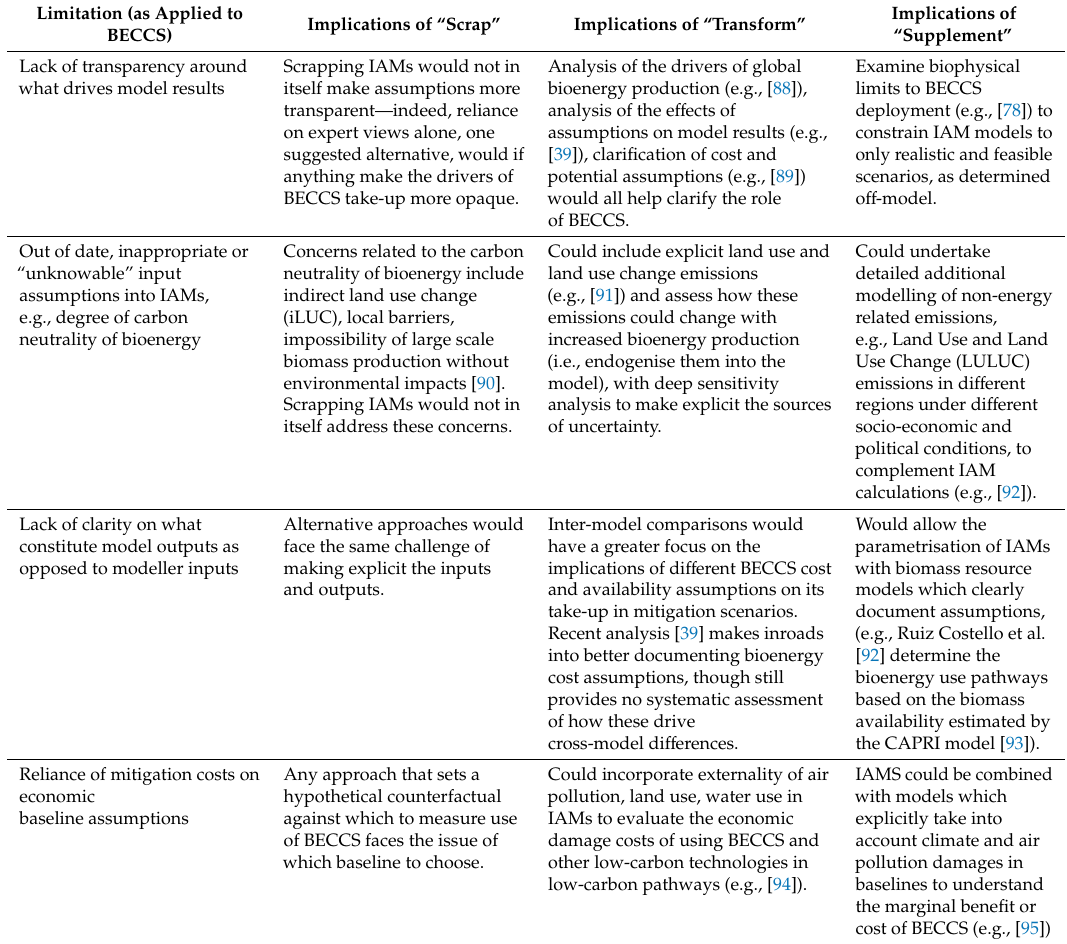
Table 2. Implications of suggested approaches on the transparency of BECCS in low-carbon